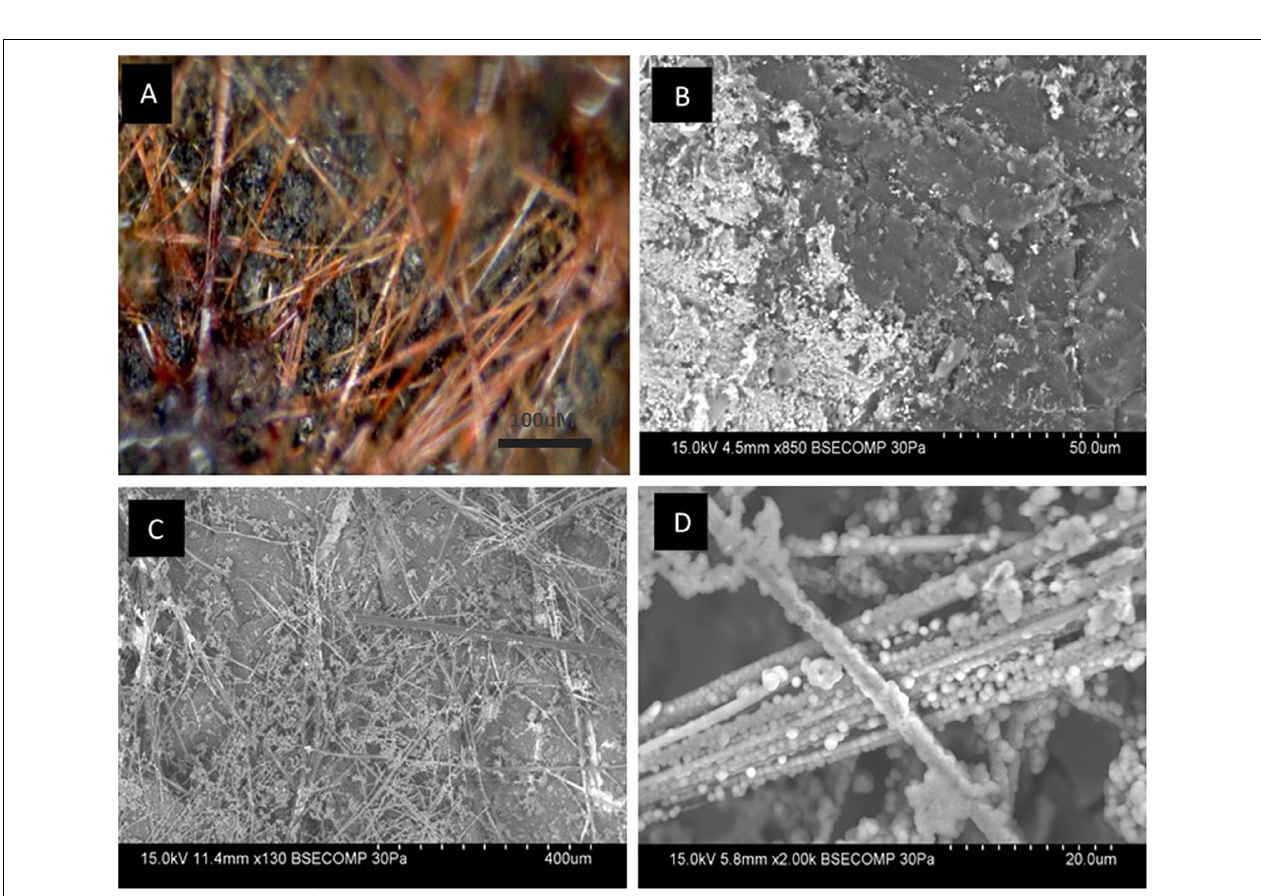
FIGURE 5 | Light and electron microscopy images of neutral red crystals on coal. (A) Crystals can be observed as a dense layer of orange-red needles randomly oriented across the coal surface (black). Needles vary in width and length. (B) Without neutral red, remnants of lysed biofilms can be seen scattered over the surface of Jharia coal. (C) For the first time, high resolution electron microscopy images of the crystalline form of neutral red were obtained through Backscattered electron microscopy. (D) Shows the nodulation over the crystalline form of neutral red caused by microbes and mineral deposition.